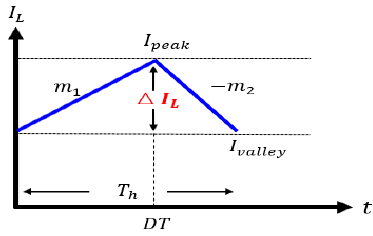
Figure 13. Steady-state inductor current.